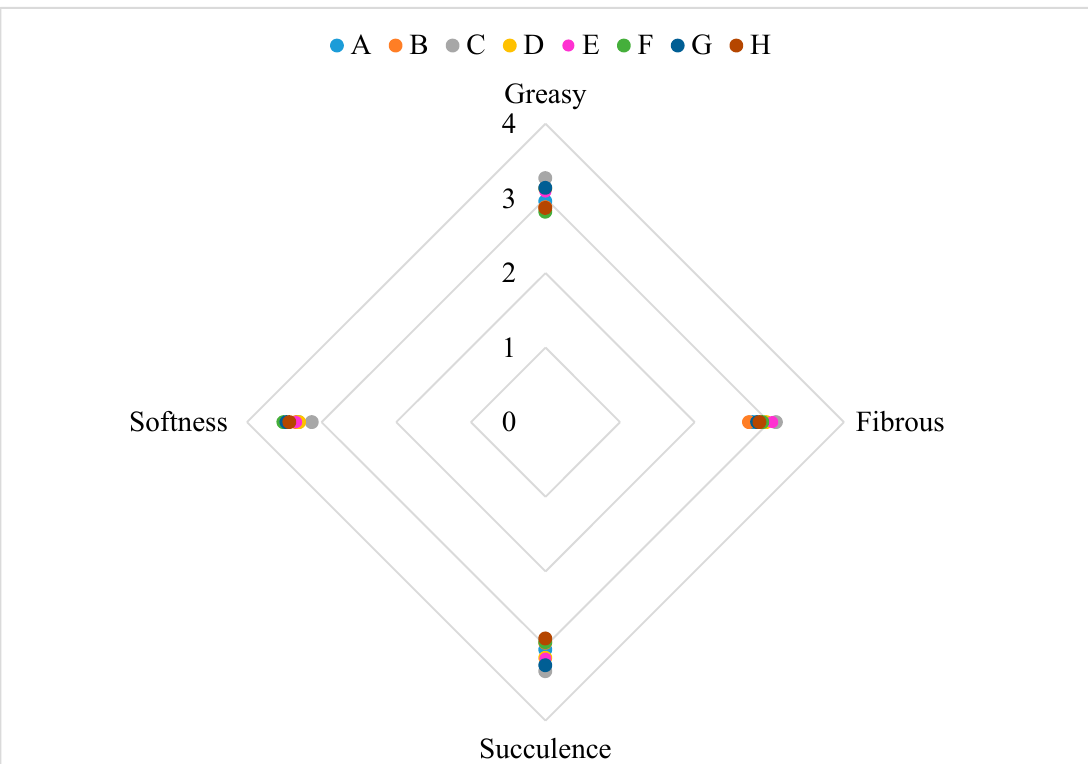
Figure 6. Results of the sensory analysis for texture descriptors. (A): Salami slice packaged with the control film during a 90-days storage period evaluated without the packaged; (B): Salami slice packaged with the control film during a 90-days storage period evaluated with the packaged; (C): Salami slice packaged with the active film during a 90-days storage period evaluated without the packaged; (D): Salami slice packaged with the active film during a 90-days storage period evaluated with the packaged; (E): Salami slice packaged with the control film during a 30-days storage period evaluated without the packaged; (F): Salami slice packaged with the control film during a 30-days storage period evaluated with the packaged; (G): Salami slice packaged with the active film during a 30-days storage period evaluated without the packaged; (H): Salami slice packaged with the active film during a 30-days storage period evaluated with the packaged.